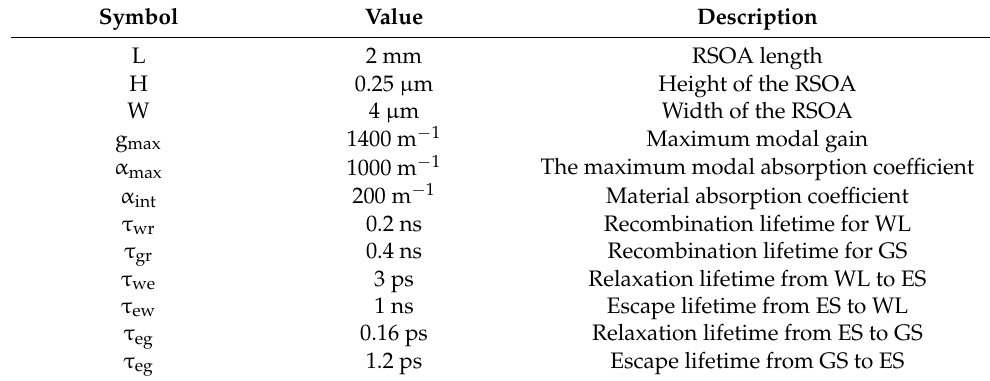
Table 1. Simulation